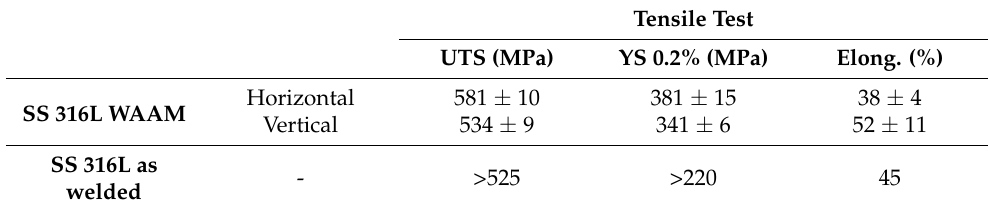
Table 4. Summary comparison of mechanical characterization on PAW-SS 316 wall in different directions.